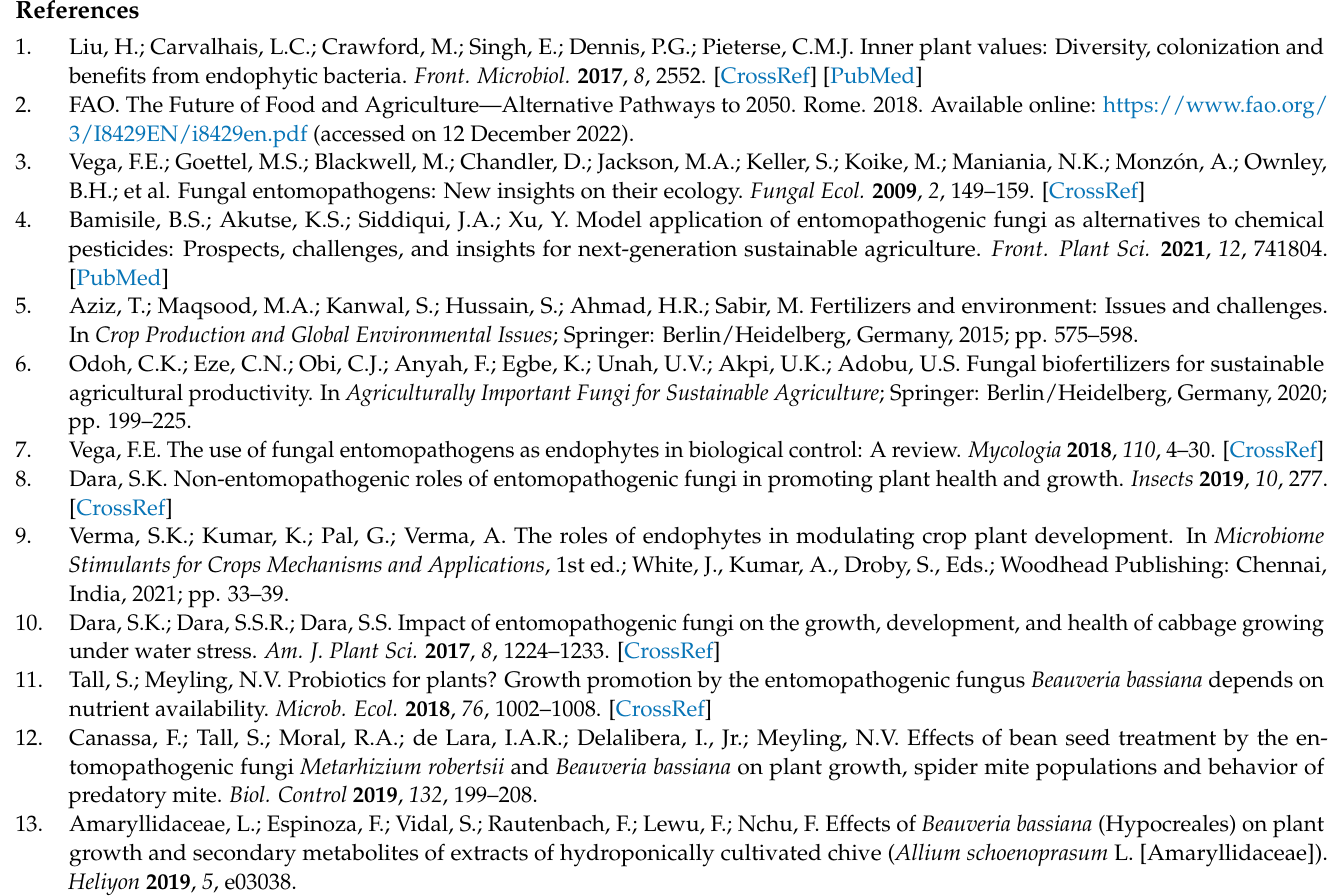
measurements; Table S2: The Shapiro-Wilk test p-values for plants length measurement. Table S3: The Kruskal-Wallis test p-values for plants length measurement. Table S4: The results of tested plants fresh weight measurements; Table S5: The Shapiro-Wilk test p-values for plants fresh weight measurement. Table S6: The Kruskal-Wallis test p-values for plants fresh weight